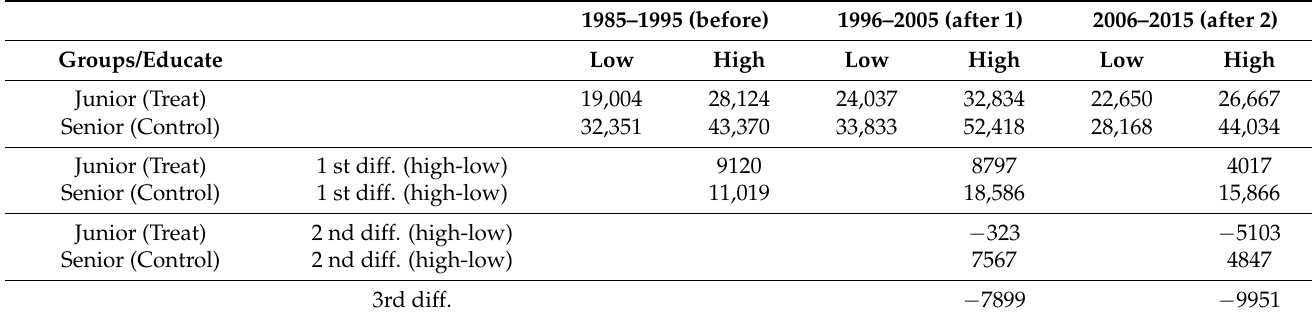
Table 2. Unconditional DDD model.